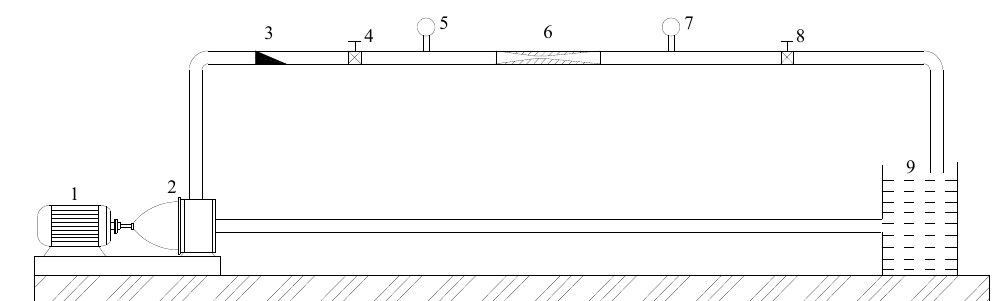
Figure 4. Structural diagram of the experimental setup. 1. Electromotor 2. Pump 3. Electromagnetic